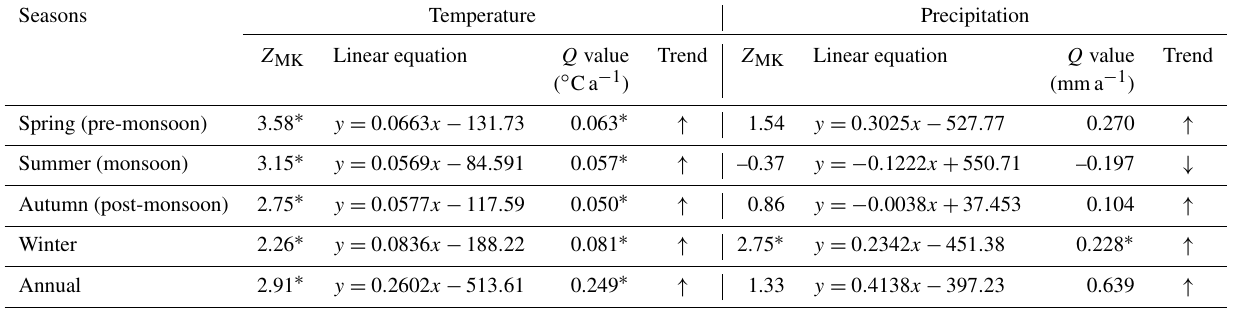
Table 8. Statistical results of the Mann–Kendall test for trend analysis of long-term annual and seasonal temperature and precipitation over the period 1960–2013. Sen’s slope ( Q ) analysis shows the rate of change in temperature ( ◦ Ca − 1 ) and precipitation (mma − 1 ).